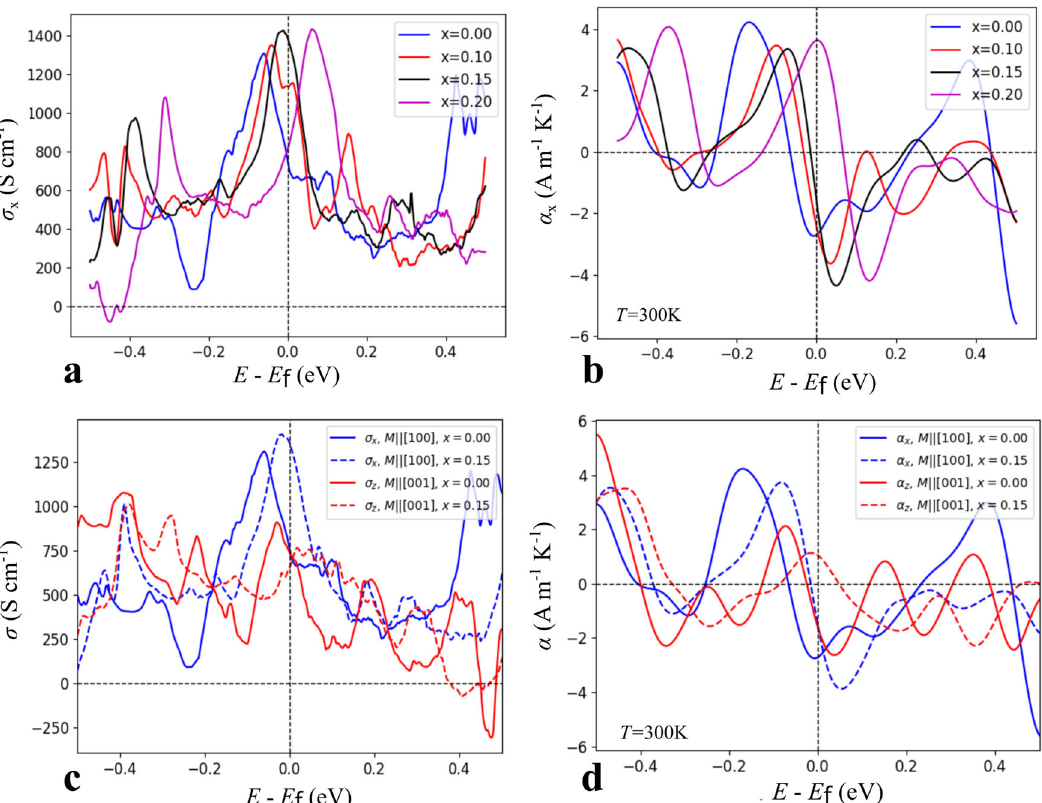
Fig. 5 Tunability of anomalous Hall and Nernst conductivities in respect to strain and magnetization direction for Fe 3 Sn. a The x-component ( σ x = σ yz ) of the full AHC as a function of energy for different doping concentrations x of (Fe 1 − x Mn x ) 3 Sn. b The x-component ( α x = α yz ) of the full ANC as a function of energy for different doping concentrations x of (Fe 1 − x Mn x ) 3 Sn. c AHC as a function of energy for different magnetization directions and doping concentrations of (Fe 1 − x Mn x ) 3 Sn. d ANC as a function of energy for different magnetization directions and concentrations of (Fe 1 − x Mn x ) 3